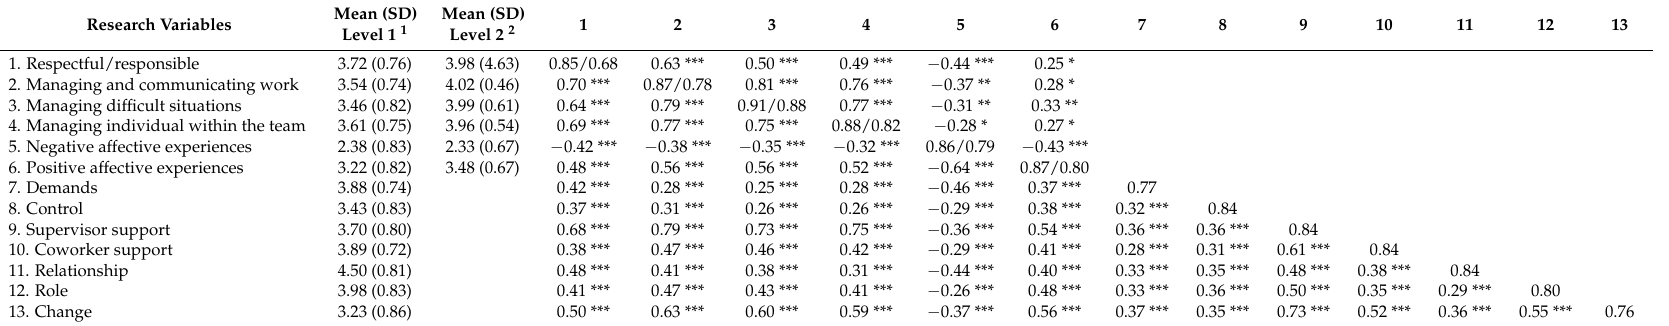
Table 2. Descriptive statistics and intercorrelations between the study